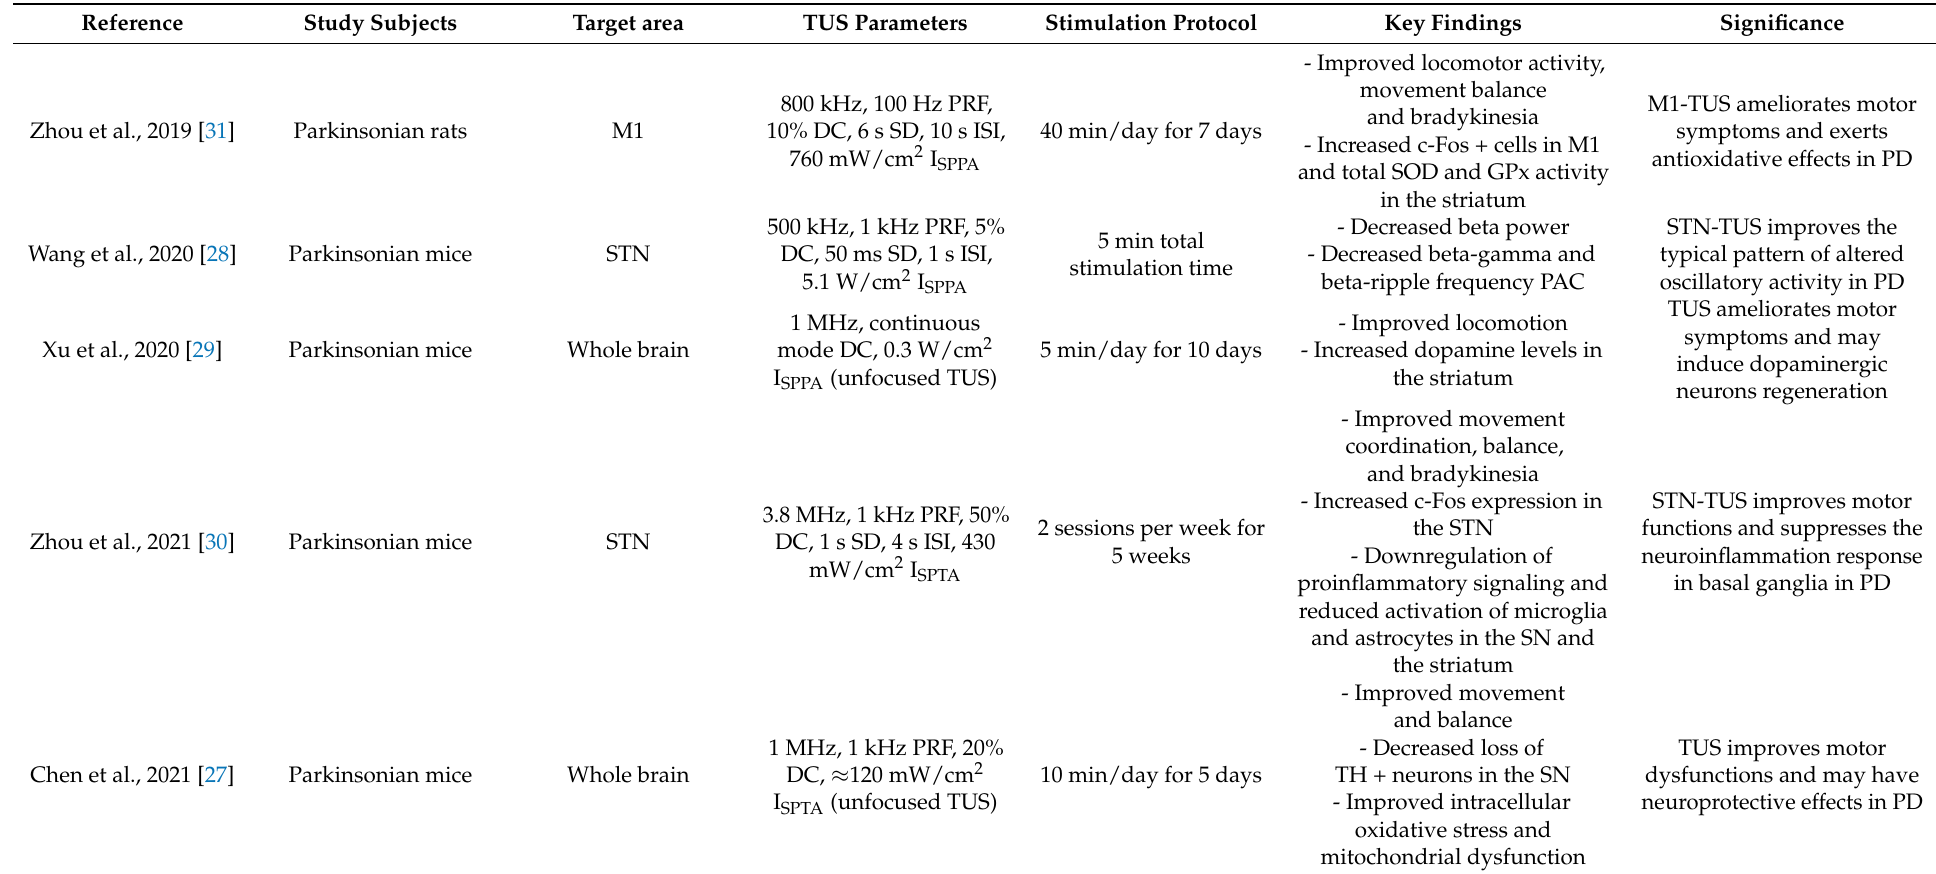
Table 1. Available TUS studies in movement